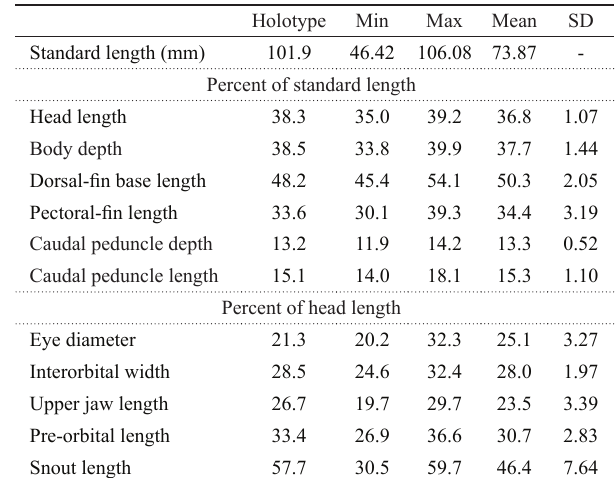
Tab. 1 . Morphometric data of Gymnogeophagus peliochely- nion , new species. Standard length is expressed in mm. Range includes measurements of holotype and 22 paratypes, except individuals smaller than 45 mm SL.